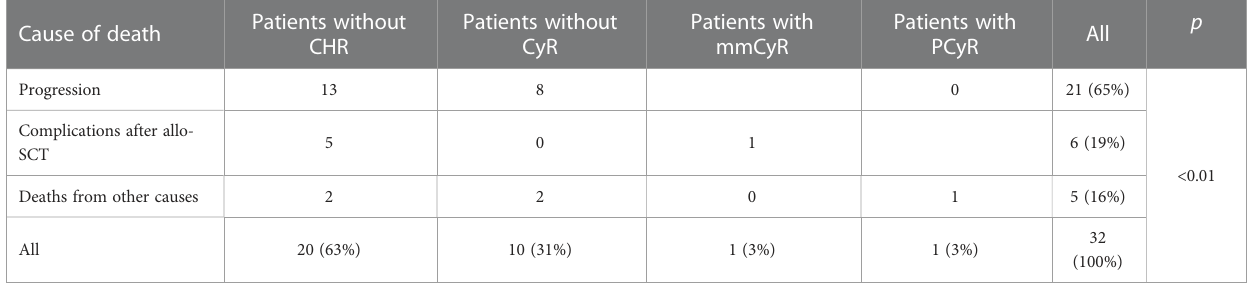
TABLE 4 Causes of death according to the depth of response at baseline.